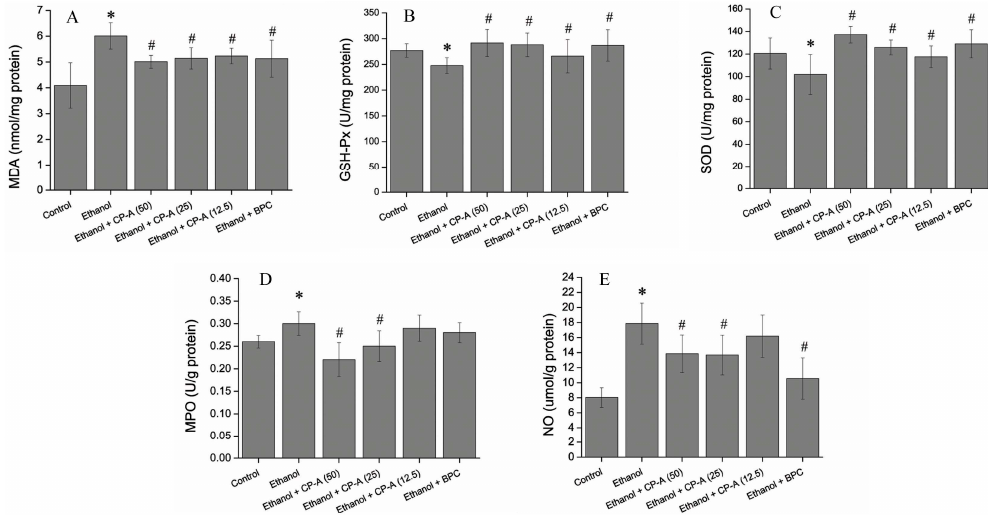
Figure 8. Effect of CP-A on MDA content ( A ); GSH-Px ( B ); SOD ( C ); MPO activity ( D ); and NO level ( E ) in ethanol-induce gastric mucosal. Data are presented as mean ± SD ( n = 10). * p < 0.05 versus Normal group; # p < 0.05 versus Ethanol group.